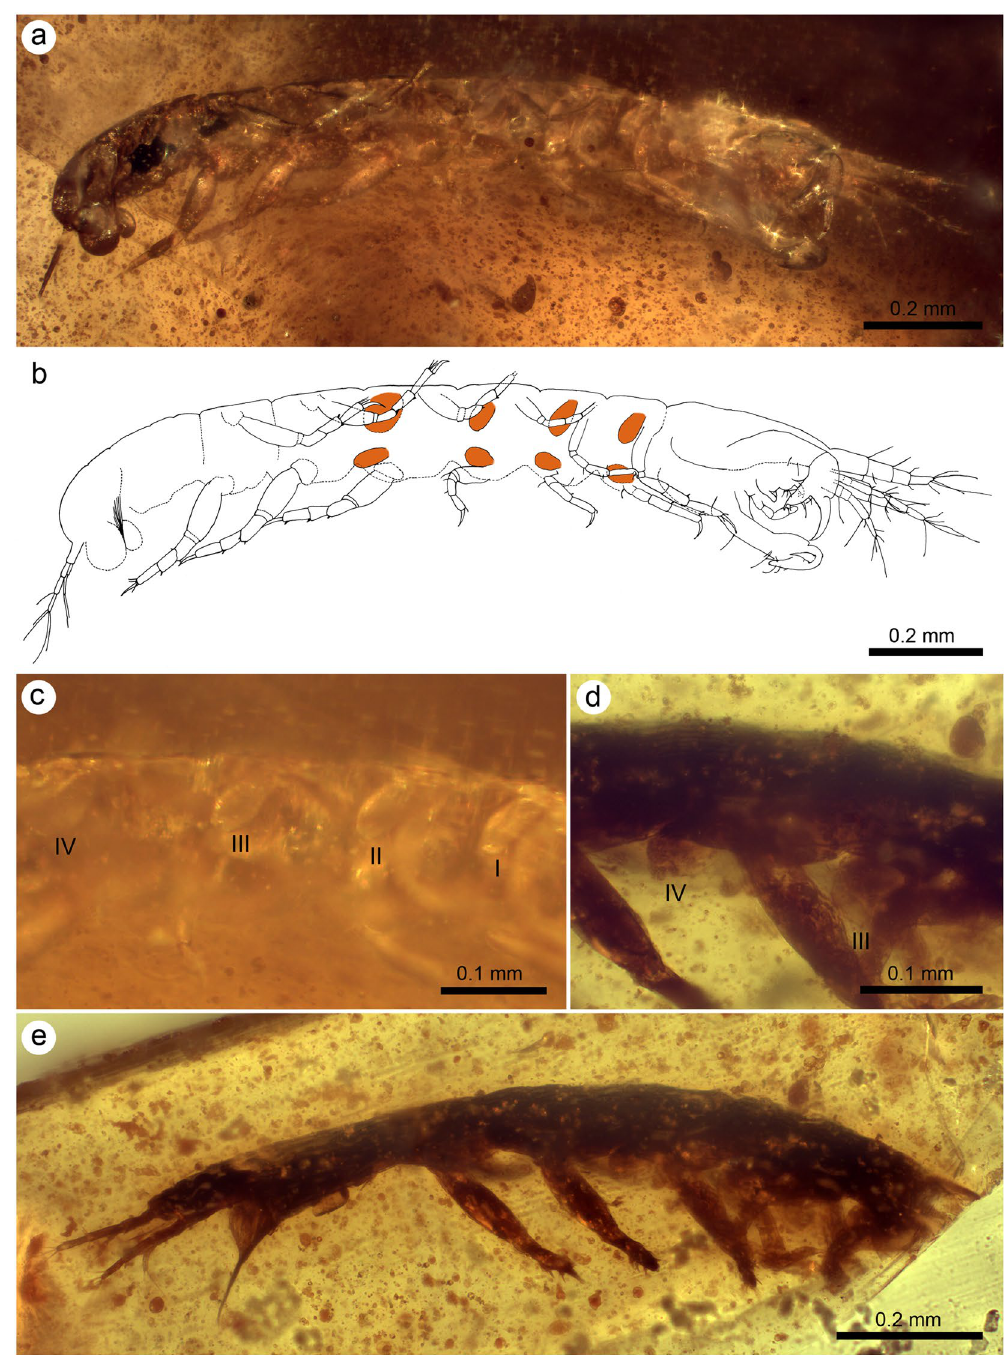
Figure 2. Female alavatanaids from the Lower Cretaceous amber of Peñacerrada I, Spain. ( a ) Lateral overview of Alavatanais margulisae (holotype MCNA 9583a) showing the oostegites; ( b ) Camera lucida drawing of the specimen in A highlighting the oostegites in orange (modified from Sánchez-García et al . 18 ); ( c ) Detail of right oostegites I–IV of the same specimen; ( d ) Detail of the third and fourth right oostegites of A . carabe (MCNA 13890); ( e ) Lateral overview of the same specimen of A . carabe showing the